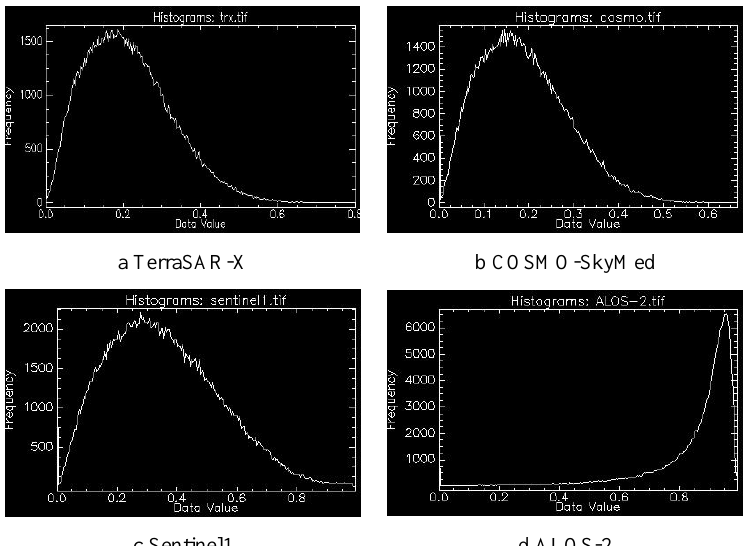
Figure 6 Coherence value of the four groups of interference pairs